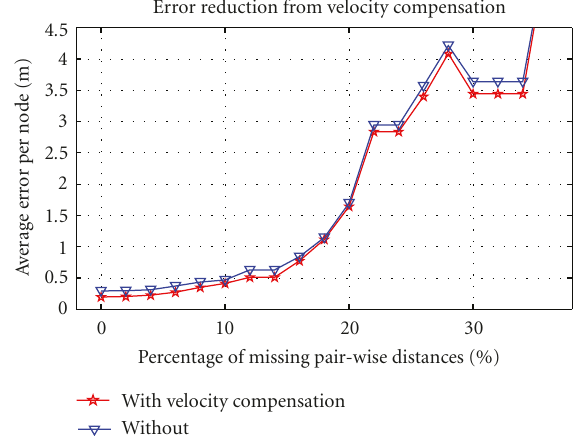
Figure 20: Reduction of error per node by velocity compensation using the average wind vector estimate.